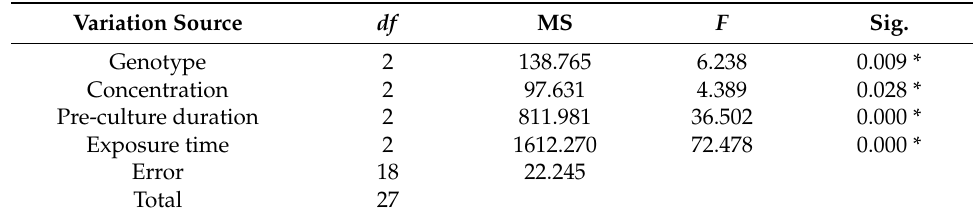
Table 5. The variation analyses of survival rates for different genotype petioles ( Liquidambar styraciflua × L. formosana ), concentration, pre-culture duration and exposure